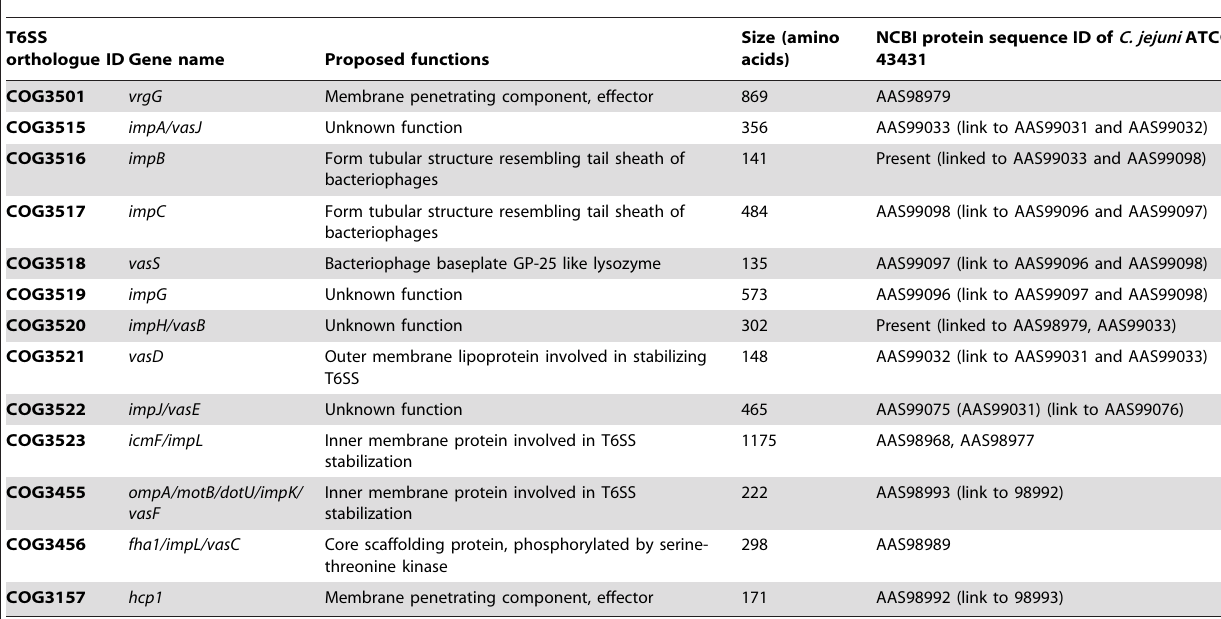
Table 1. List of T6SS orthologs of C. jejuni ATCC 43431 and their proposed functions [3,24].